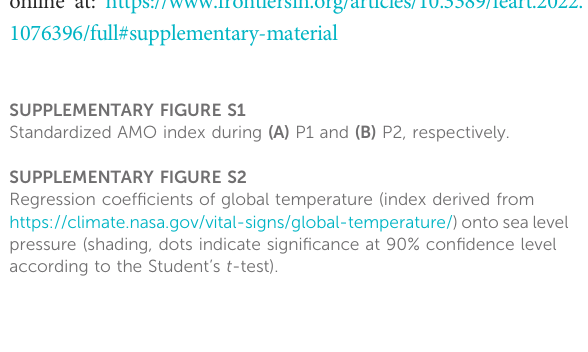
SUPPLEMENTARY FIGURE S1 Standardized AMO index during (A) P1 and (B) P2, respectively. SUPPLEMENTARY FIGURE S2 Regression coef fi cients of global temperature (index derived from https://climate.nasa.gov/vital-signs/global-temperature/)onto sea level pressure (shading, dots indicate signi fi cance at 90% con fi dence level according to the Student ’ s t -test).